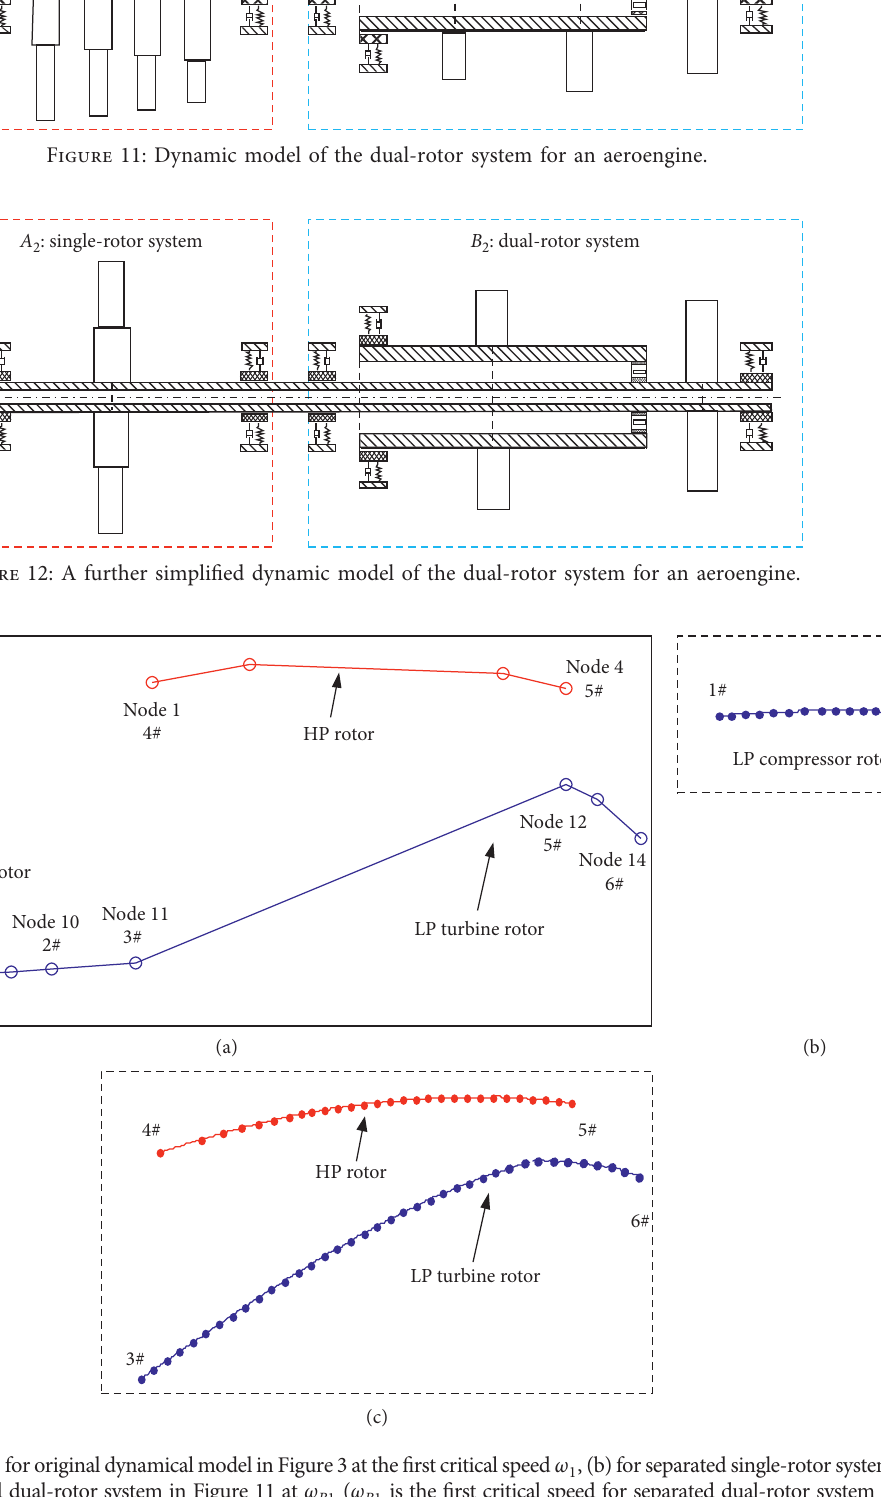
, (b)forseparated single-rotorsysteminFigure 11 1 ( ω B is the first critical speed for separated dual-rotor system in Figure 11). 1 1